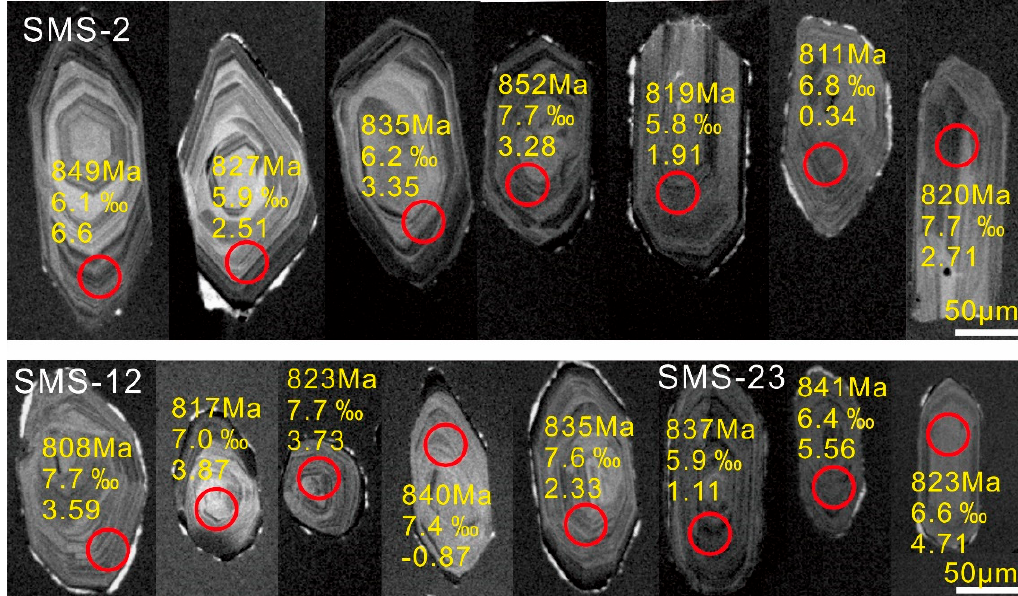
Figure 7. CL images of representative zircons from the Neoproterozoic Shimensi granodiorite. Yellow numbers (from top to bottom) denote the U–Pb age, δ 18 O and ε Hf(t), respectively. Red circles show the analysis spots.